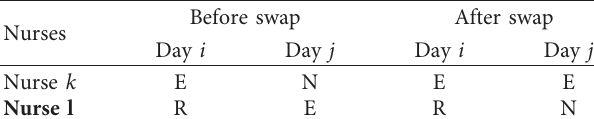
Table 10: An example of